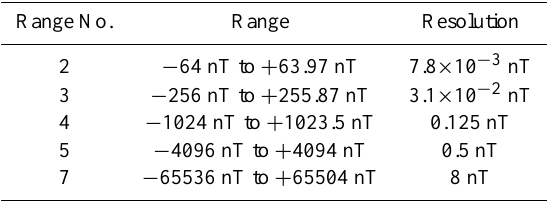
Table 1. Operative ranges for the FGM (not all used) Range No.